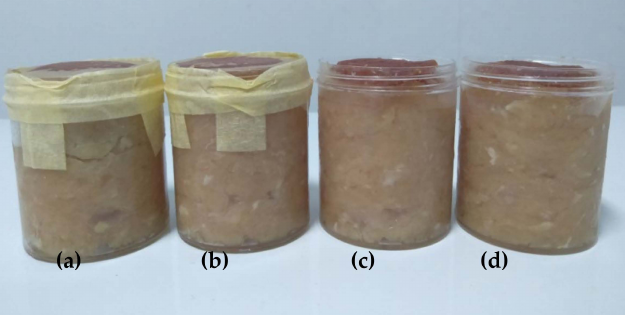
Figure 5. Illustration of the application model of the bionanocomposite film: meat samples packaged with film ( a , b ) and without film ( c , d ).